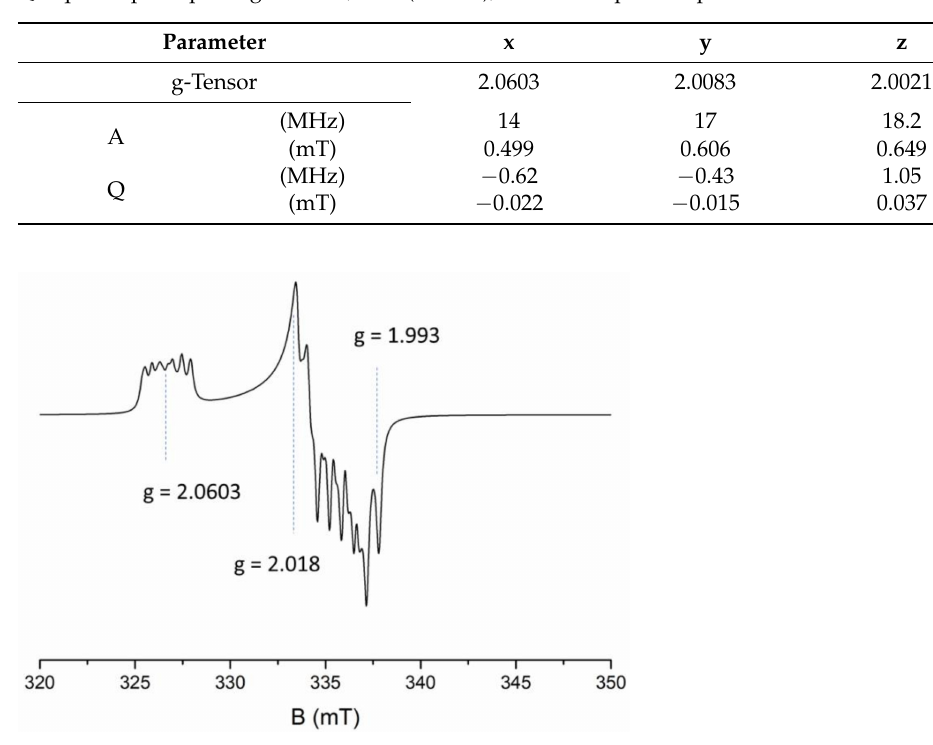
Table 1. Spin Hamiltonian parameters used for simulating [AlO 4 ] 0 spectrum. A—hyperfine splitting, Q—quadrupole splitting. S = 1/2, 27 Al (I = 5/2), Lorentzian peak-to-peak linewidth 0.185 mT.